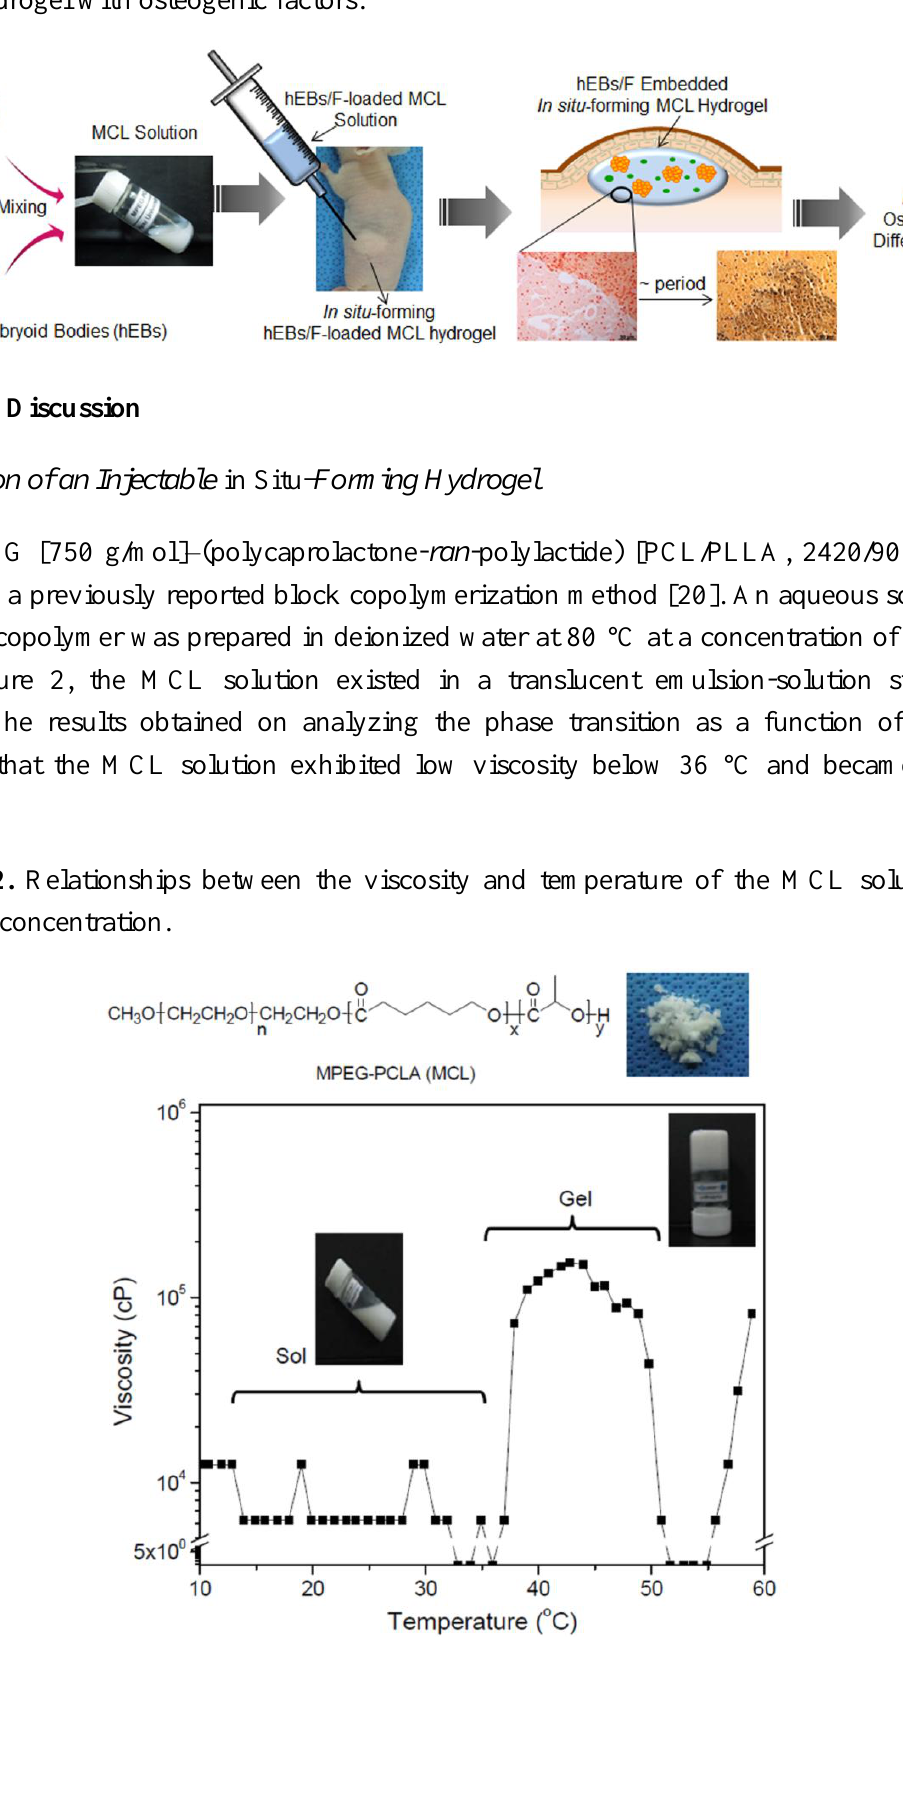
Figure 1. Schematic representation of in vivo osteogenic differentiation of human embryoid bodies (hEBs) in an injectable in situ -forming MPEG- b -(polycaprolactone- ran -polylactide) MCL hydrogel with osteogenic factors.